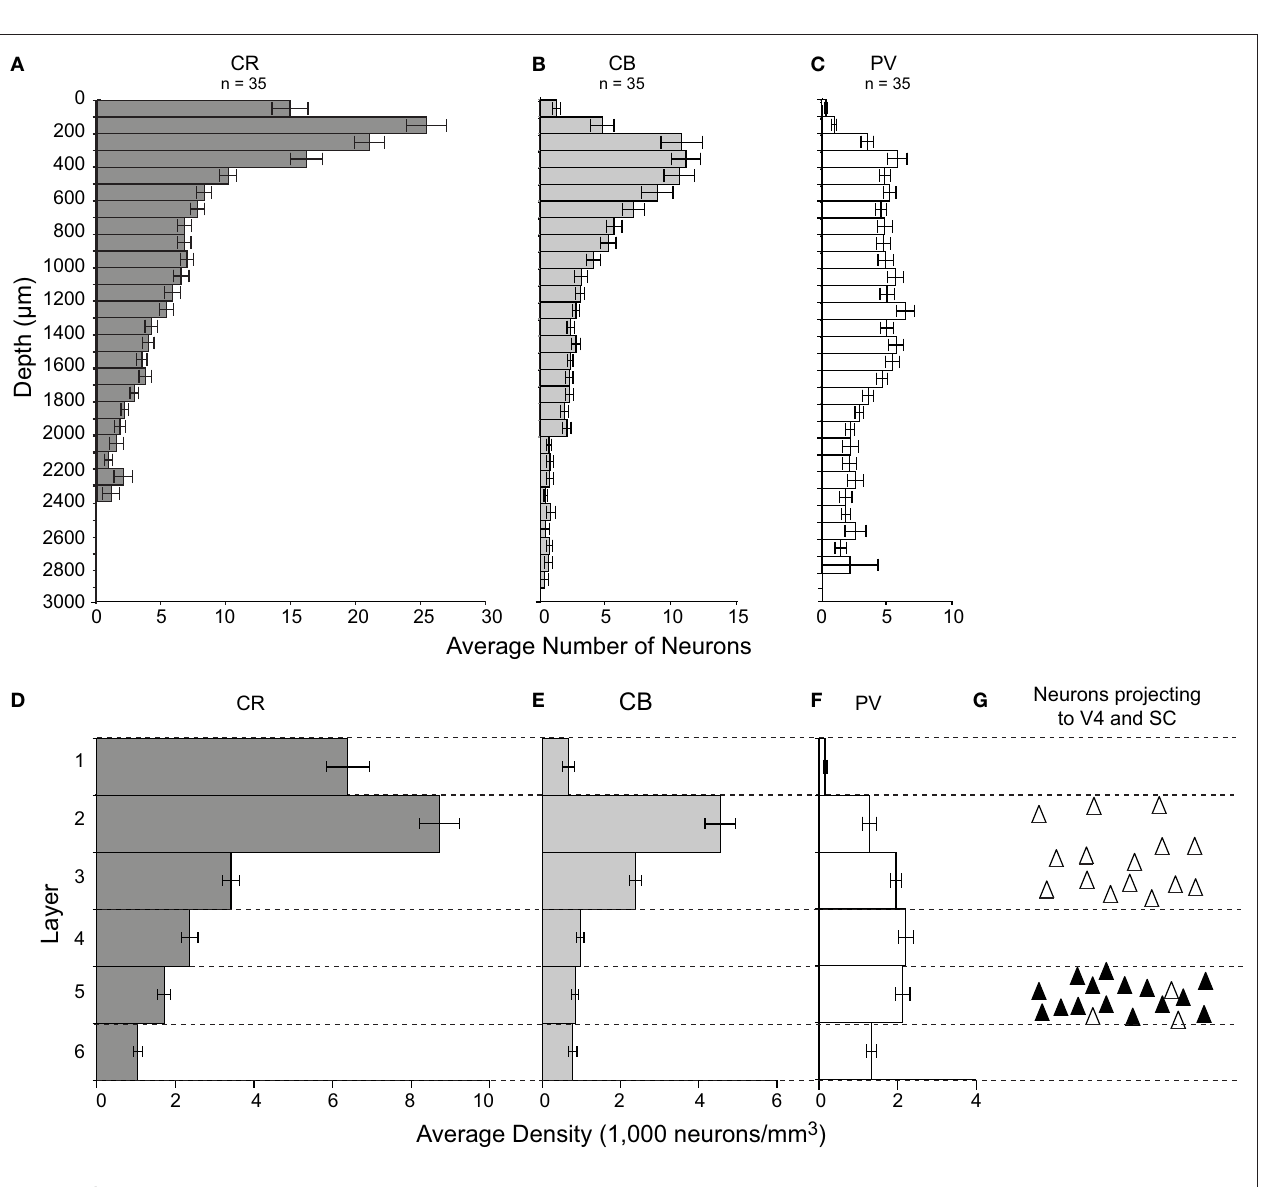
density of neurons in each layer, and the thickness of the bars has no relationship to the thickness of the layer. Notice the difference in laminar distribution of different populations of calcium-binding proteins. (G) A schematic distribution of FEF neurons projecting to SC (black triangles) and to V4 (white